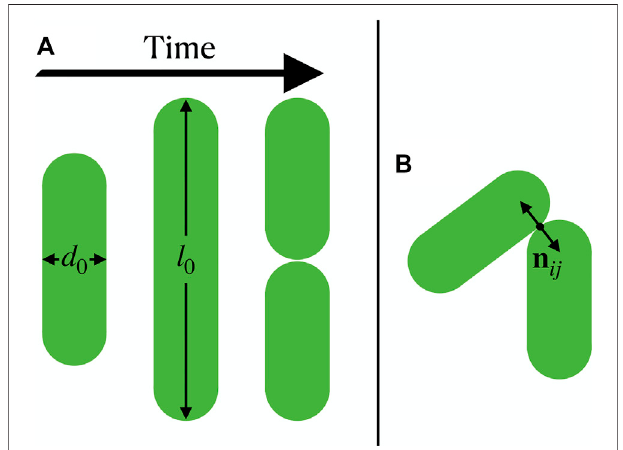
FIGURE 1 | Growing bacteria modeled as expanding rods. (A) A rod grows, reacheslength l 0 and splitsintotwo. (B) Interactionbetween tworods, where the normal vector n ij of the particles ’ closest point of contact is